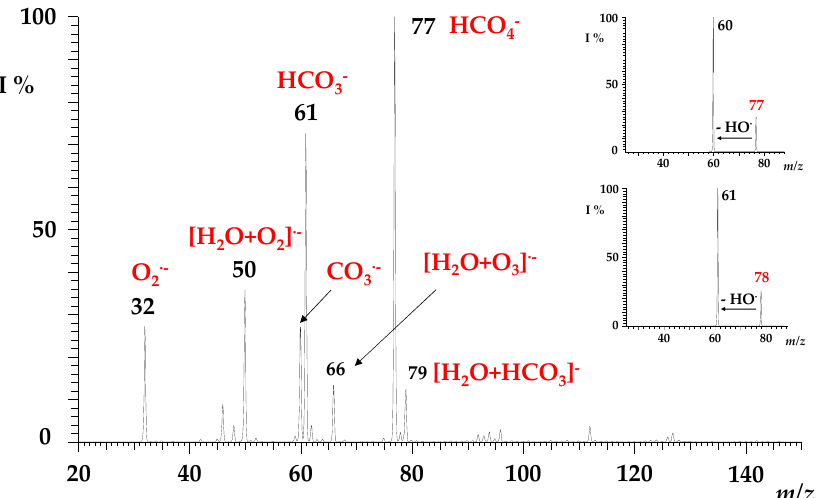
Figure 1. Mass spectrum for the electrospray of water acquired in the negative ion mode in the m/z range of 20–150. Inset: MS/MS of HCO 4 − ions at m/z = 77 (upper) and H 13 CO 4 − ions at m/z = 78 (lower). See text for details.